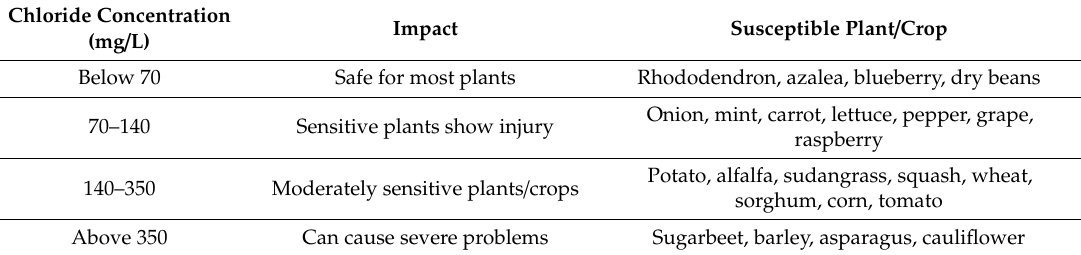
Table 3. Chloride concentration impact on various classes of plants and